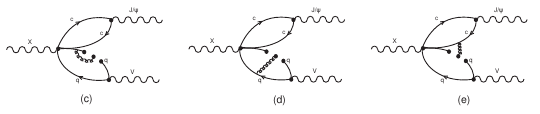
Fig. 5. Non-perturbative corrections to the leading order dia- grams of the X